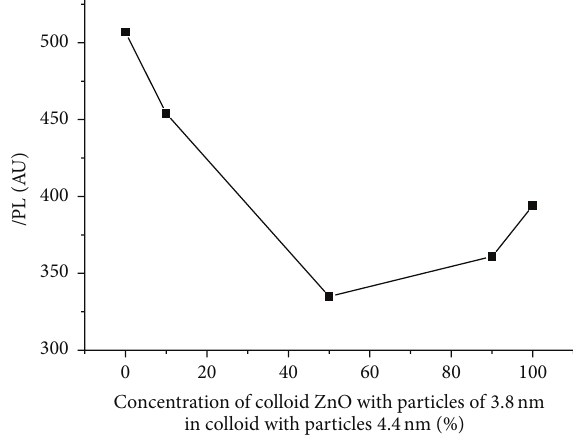
(Figure 6, inset, curve 2) is greater in comparison with the width of derivative for the particle size of 4.4 nm (Figure 6, inset, curve 1). This may be due to broader distribution